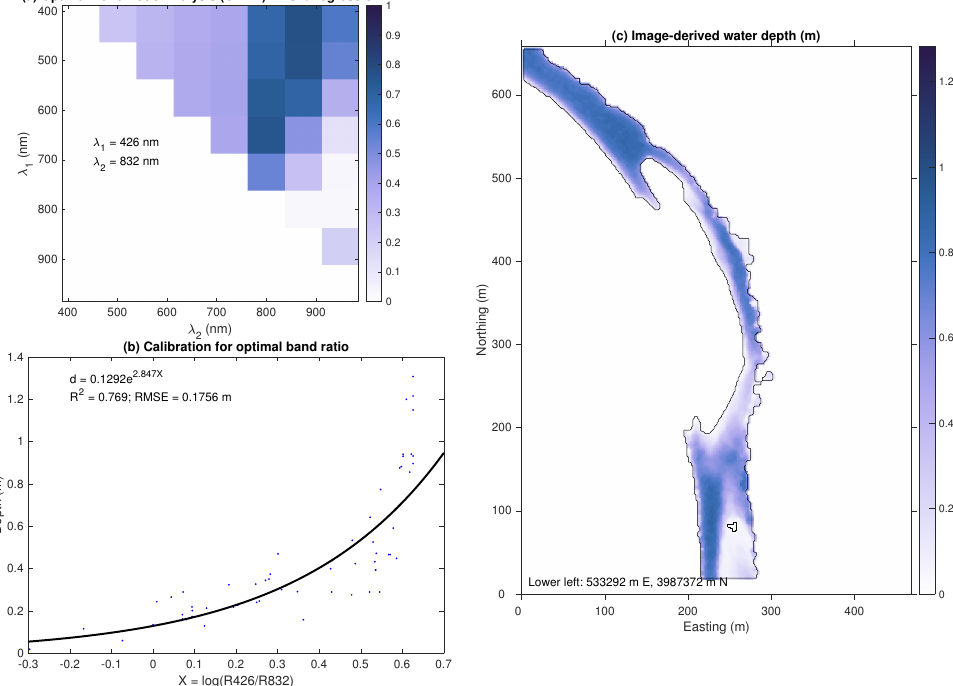
Figure 7. Optimal band ratio analysis (OBRA) of the September 15 WorldView3 image of the Maumee reach. ( a ) Matrix representing the strength of the X vs. d relation for each possible combination of numerator λ 1 and denominator λ 2 bands in terms of the regression R 2 . ( b ) Calibrated relationship between X and d for the optimal band ratio. ( c ) Depth map produced by applying this relation to the spatially filtered water-only